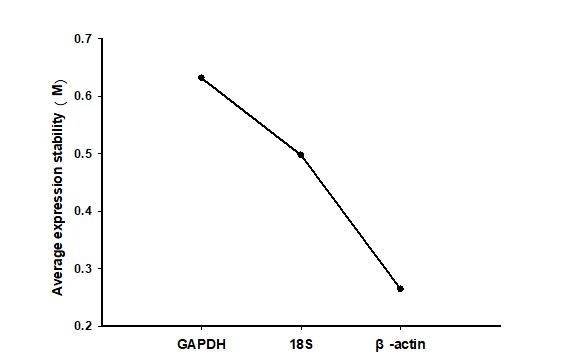
Gene expression stability of reference genes in different stage of gregarious and solitary locusts as calculated by geNorm (Vandesompele et al., 2002).